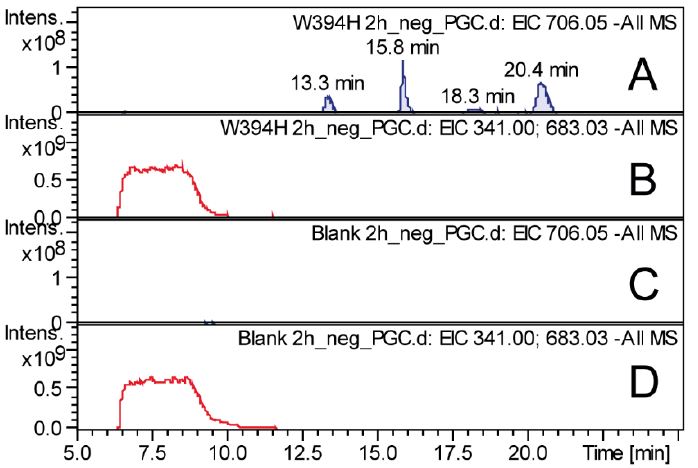
Figure 5. Porous graphitized column chromatography of a representative sample in negative mode. Extracted ion chromatograms of LNT isomers (blue, m / z 706 [M−H] ₋ ) and lactose (red, m / z 341 [M−H] ₋ + m / z 683 [2M−H] ₋ ) in a sample ( A , B ) and a blank reaction without enzyme ( C , D ).